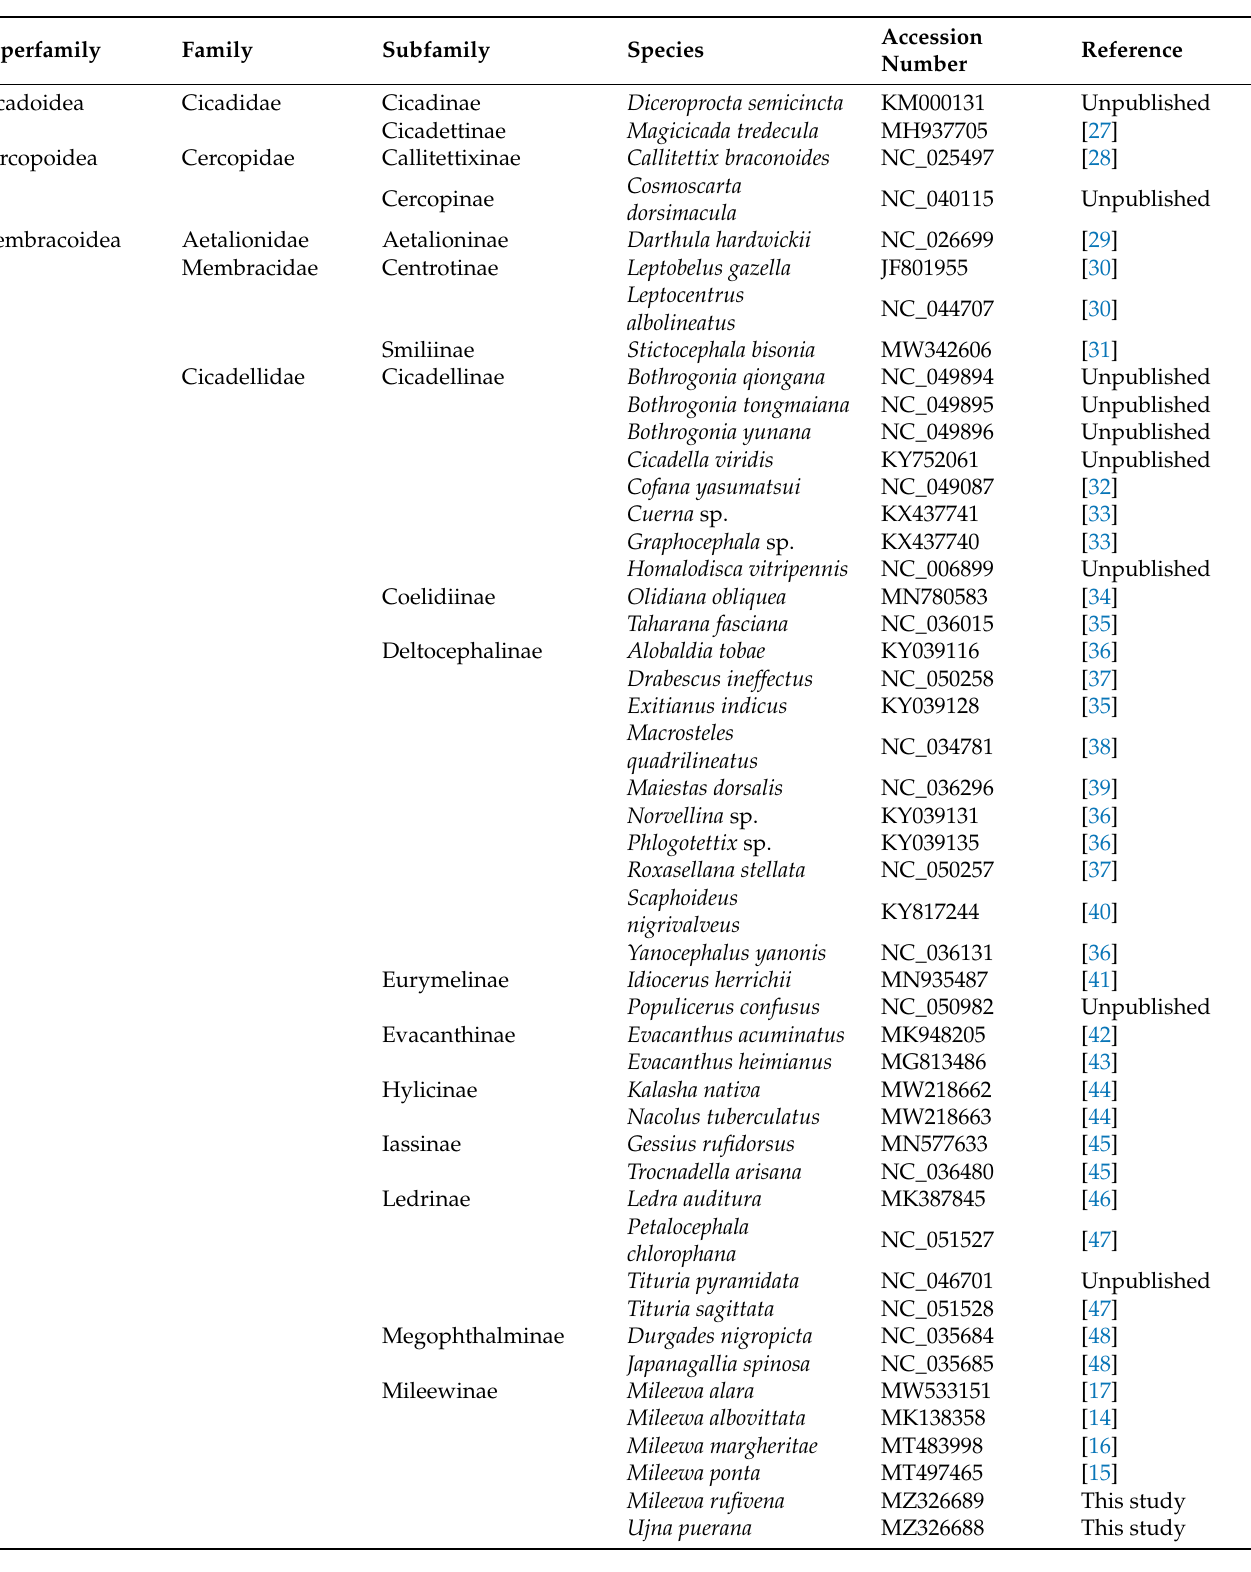
Table 1. List of mitogenomes used for phylogenetic